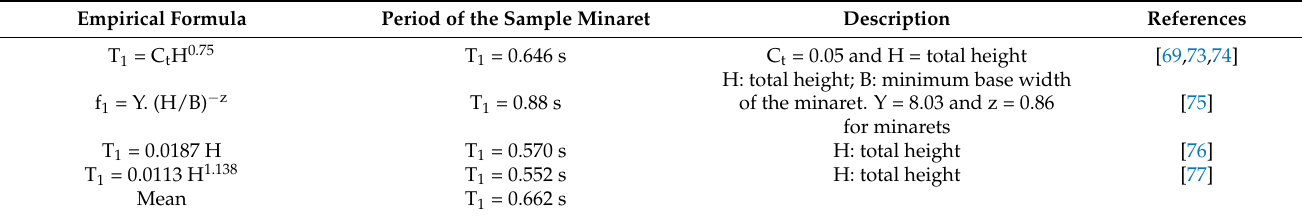
Table 10. Suggested empirical formula for fundamental